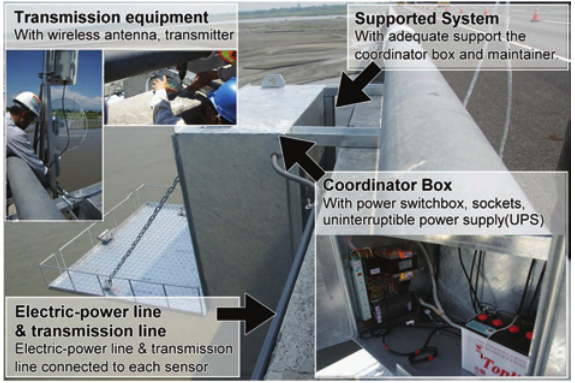
Fig. 6. The coordinator box diagram